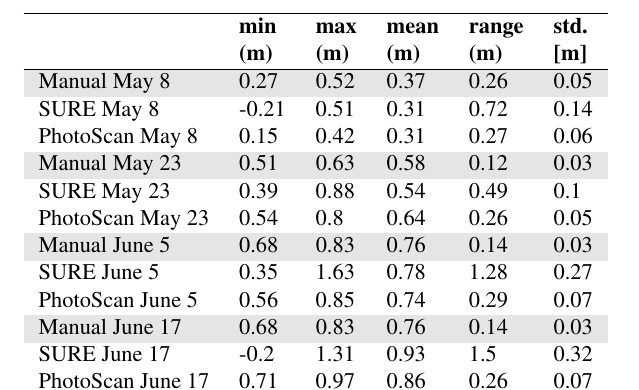
Table 1. Descriptive statistics of plot-wise mean heights of man- ual measurements and generated CSMs for plots with point den- sity greater than 100/ m 2